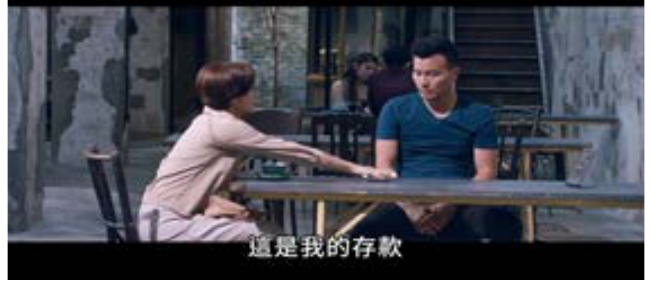
Fig. 5: Sunny’s sister giving him money for his